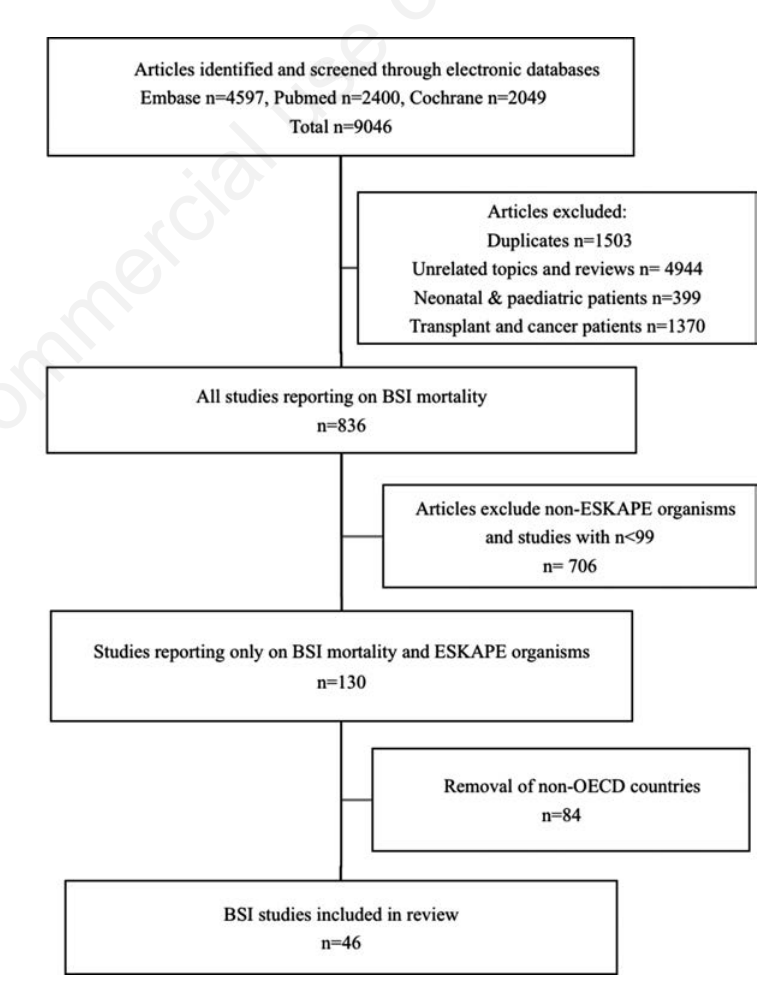
Figure 1 Search strategy to identify studies of bloodstream infections (BSI) and mortality or quality of life measures, from the Organization for Economic Cooperation and Development (OECD)